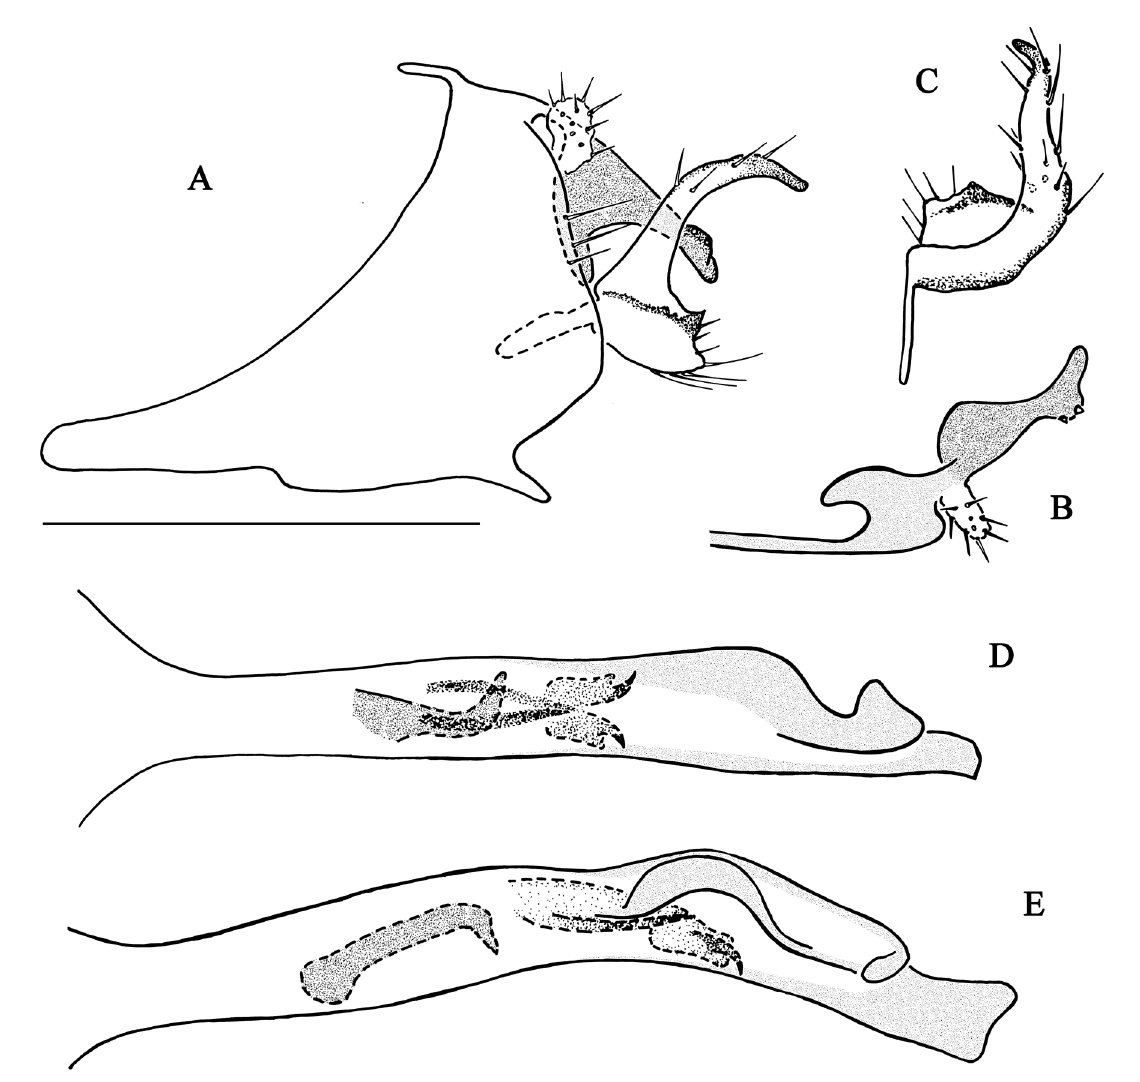
Fig. 7. Chimarra gattolliati sp. nov. A–B . Abdominal segments IX and X. A . Lateral view. B . Dorsal view (partim). C . Inferior appendage, dorsal view. D–E . Phallic apparatus. D . Dorsal view. E . Lateral view. Scale bar = 0.5